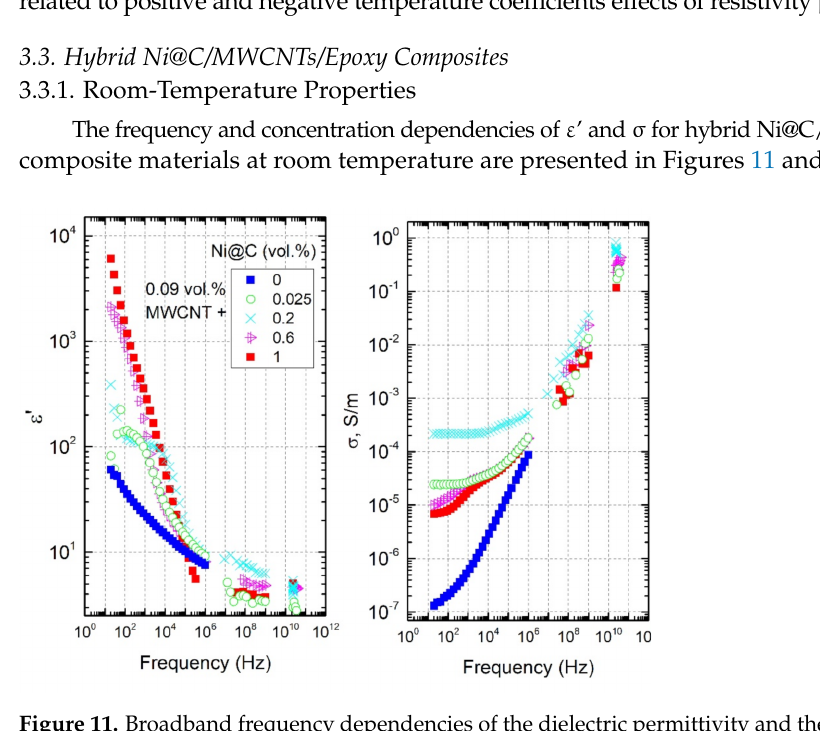
Figure 11. Broadband frequency dependencies of the dielectric permittivity and the electrical conduc- tivity of hybrid Ni@C/MWCNTs/epoxy composites with fixed MWCNTs concentration of 0.09 vol.% and different Ni@C content at room temperature.